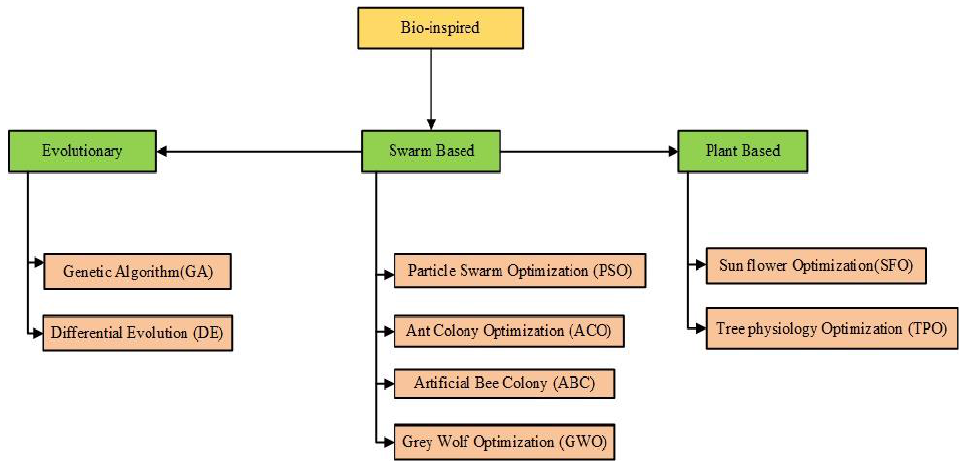
Figure 2. Taxonomy of Bio-inspired Optimization Techniques